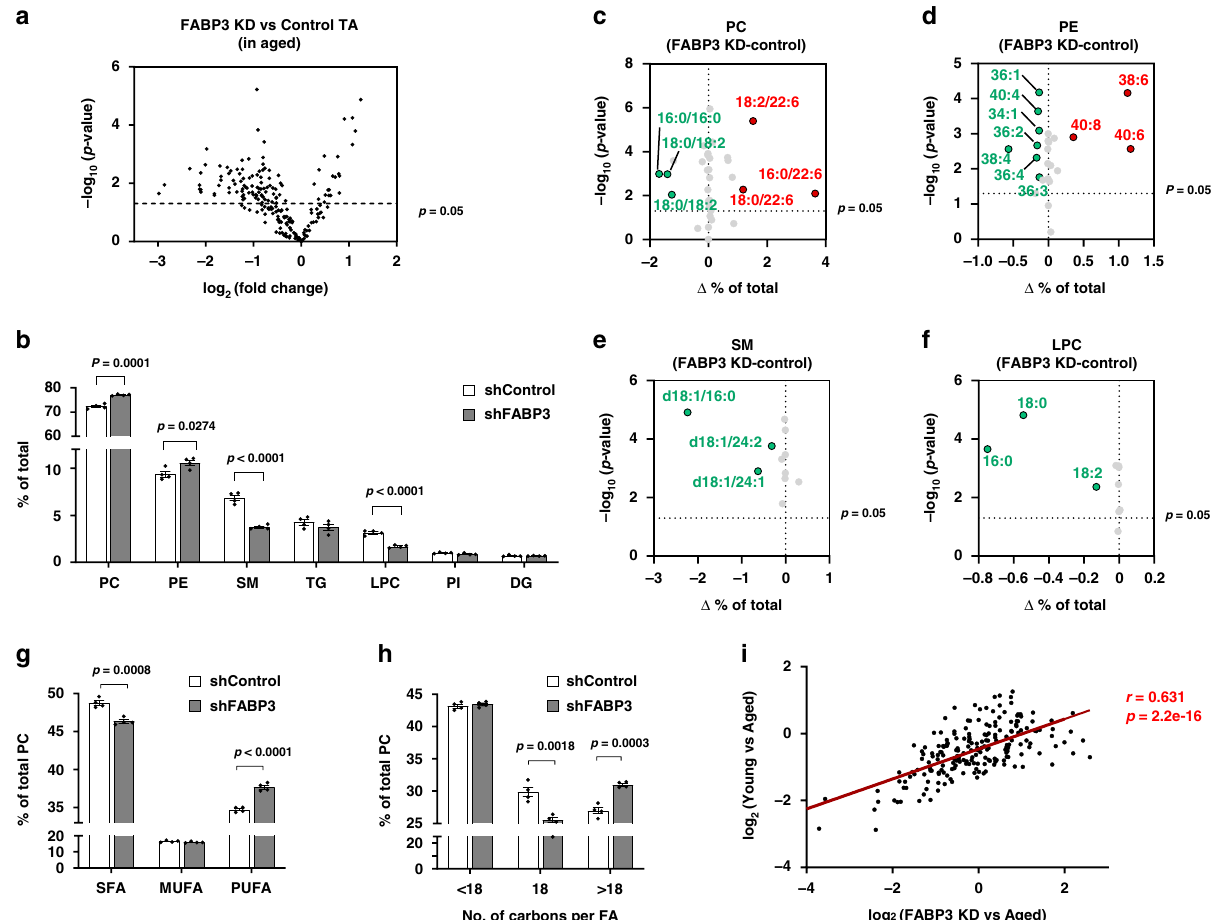
Fig. 5 FABP3 inhibition in aged muscle results in young-like lipid composition. a Volcano plot of lipid species altered in FABP3-knockdown aged vs. control muscle. Lipid species were measured by LC-MS. The x -axis indicates logarithmic (base 2) fold abundance changes of all identi fi ed lipid species and the y -axis indicates negative logarithmic (base 10) t -test p -value. The horizontal dotted line re fl ects the fi ltering criterion ( p -value = 0.05). ( n = 4 mice per group) b Proportion of major lipid classes in FABP3-knockdown and control aged muscles. c – f Volcano plot of PC ( c ), PE ( d ), SM ( e ), LPC ( f ) species altered in FABP3-knockdown vs. control aged muscles. The x -axis indicates the percentage changes (FABP3KD-control-aged muscle) of lipid species and the y -axis indicates negative logarithmic (base 10) t -test p -values. The horizontal dotted line re fl ects the fi ltering criterion ( p -value = 0.05). Red and green indicate highly increased and decreased lipid species, respectively. g Proportion of SFA, MUFA, or PUFA PC acyl chains in FABP3-knockdown and control- aged muscles. h Proportion of <C18, C18, or >C18 PC acyl chains in FABP3-knockdown and control-aged muscles. The data are presented as means ± S.E. M. Two-tailed unpaired Student ’ s t -test was used. i Correlation analys i s of the total identi fi ed lipid species in the indicated comparative condition. The x - axis indicates logarithmic (base 2) fold concentration changes of all identi fi ed lipid species in FABP3-knockdown aged vs. aged muscle and the y -axis indicates logarithmic (base 2) fold changes in aged vs. young muscle. Data in i were analyzed using Spearman ’ s correlation; correlation coef fi cient ( r ) and p- value ( p ) are in red. Source data are provided as a Source Data fi